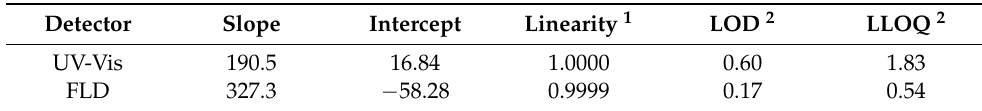
Table 2. Properties of the calibration curve were obtained using a fluorescence detector and UV detector to quantify RB with LOD and LOQ values ( n = 6).